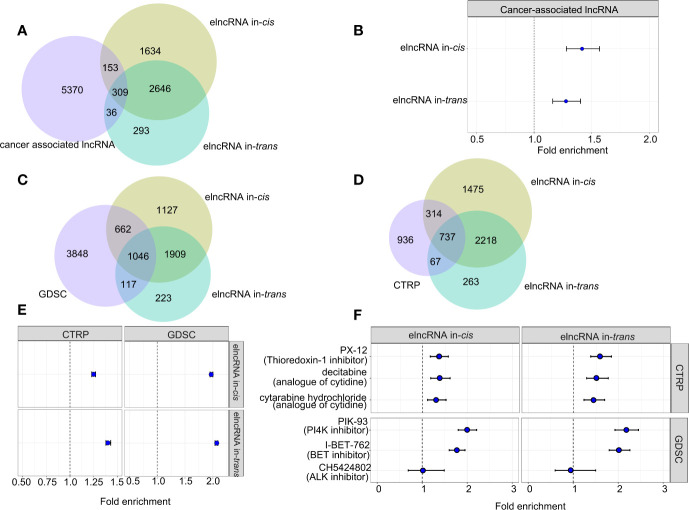
Association between elncRNAs, cancers and drugs. (A) Venn diagram showing the overlap among elncRNAs in-cis, elncRNAs in-trans and cancer-associated lncRNAs annotated by lncRNADisease v2.0. (B) Forrest plot showing the enrichment of elncRNAs in-cis and elncRNAs in-trans in cancer-associated lncRNAs. (C) Venn diagram showing the overlap among elncRNAs in-cis, elncRNAs in-trans and predictive lncRNAs for drugs in GDSC database. (D) Venn diagram showing the overlap among elncRNAs in-cis, elncRNAs in-trans and predictive lncRNAs for drugs in CTRP database. (E) Forrest plot showing the enrichment of elncRNAs in-cis and elncRNAs in-trans in predictive lncRNA for all drug sensitivity in two databases. (F) Forrest plot showing the enrichment of elncRNAs in-cis and elncRNAs in-trans in predictive lncRNA for the selective drug sensitivity in two databases (Fisher test).